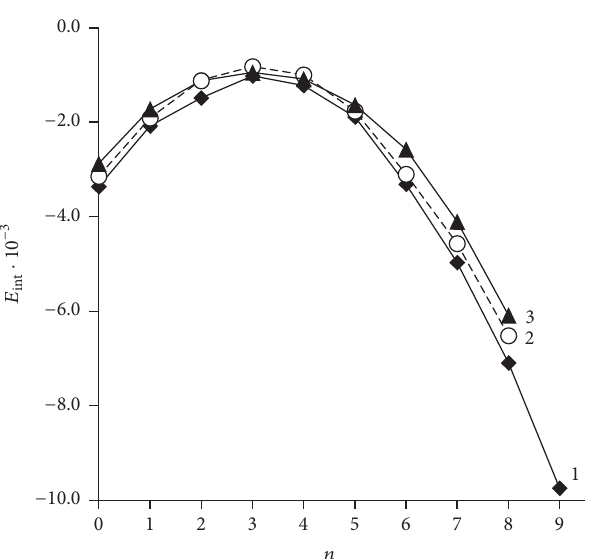
Figure 4: The Δ E value (kJ/mol) in systems M 3 CrCl 6 + 18MCl versus the number of OS cations for ( 1 ) Na, ( 2 ) K, and ( 3 ) Cs. Explanation in the